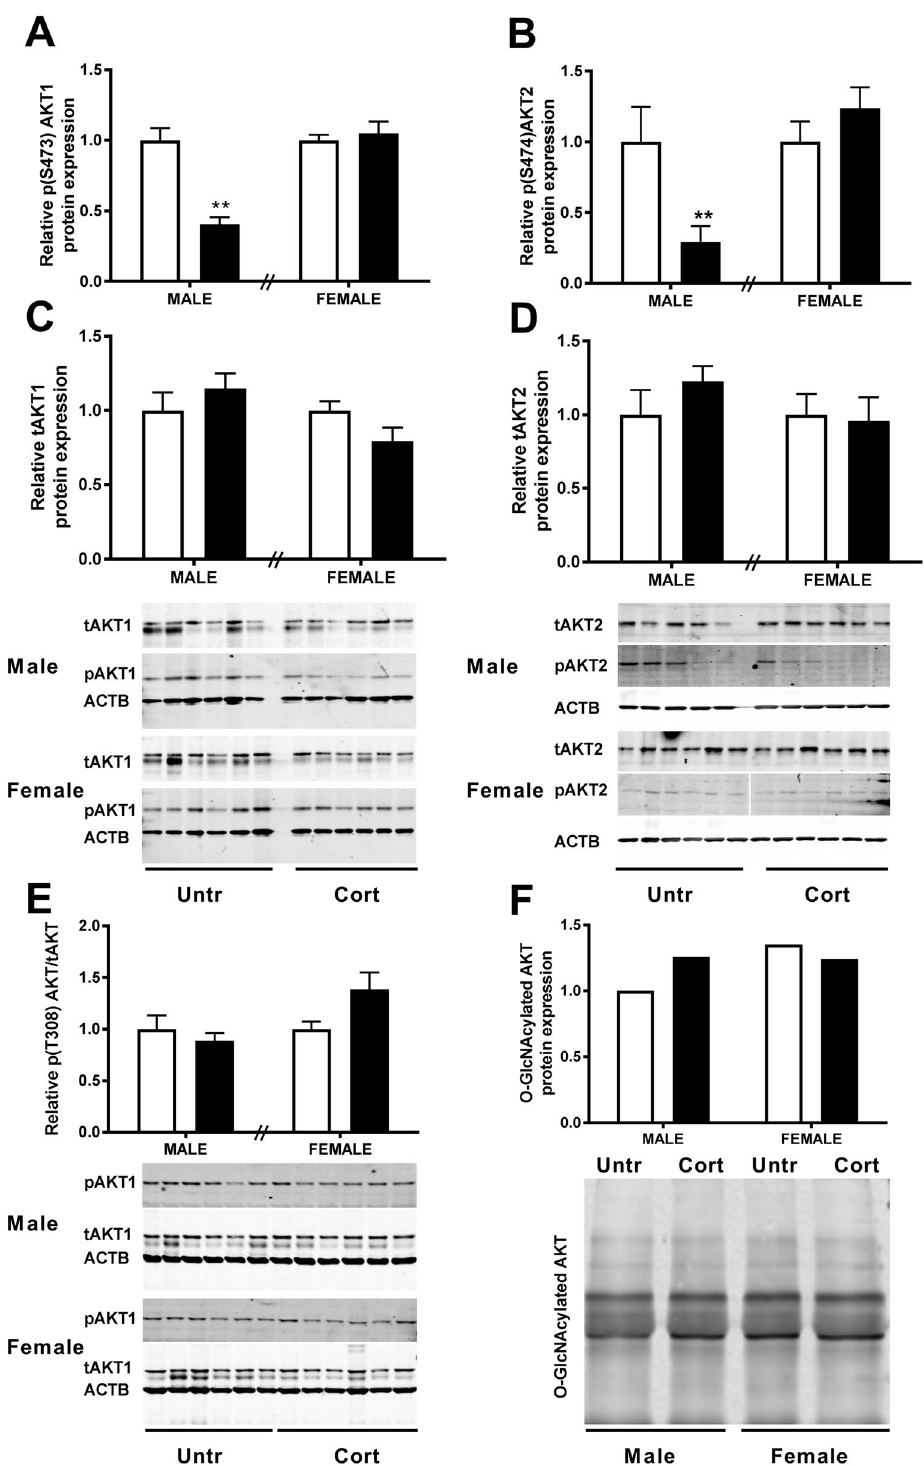
Figure 4. The effects of corticosterone exposure (black bars) on ( A ) serine 473 phospho-AKT1, ( B ) serine 474 phospho-AKT2 along with ( C ) total AKT1 and ( D ) total AKT2 protein in whole placentae of male and female C57/BL6 mouse fetuses at E14.5 compared with untreated controls (white bars). ( E ) Phosphorylation of AKT1 on threonine 308 relative to total AKT1 was also examined. Pooled male and female E14.5 placental tissue (n = 6) was further immunoprecipitated with RL2 antiserum to isolate O-GlcNAcylated proteins and immunoprobed with pan Akt antiserum following SDS-PAGE ( F ). Data represents mean + SEM, ** P < 0.01. Protein expression examined by western blot with β -Actin (ACTB) as loading control, normalised to untreated control of the same sex (Top band analysed for tAKT and both bands analysed for O-GlcNAcylated AKT). Analysed using a two-tailed t- test with untreated controls of the same sex (n =